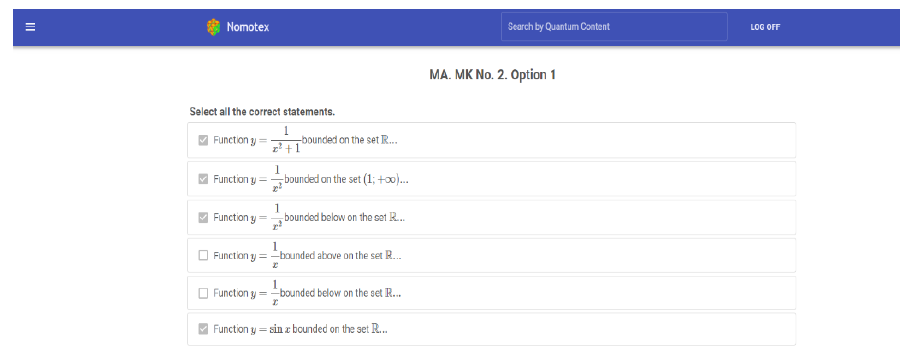
Fig. 7. Lecture microcontroller example at the Nomotex DLS. Course «Mathematical